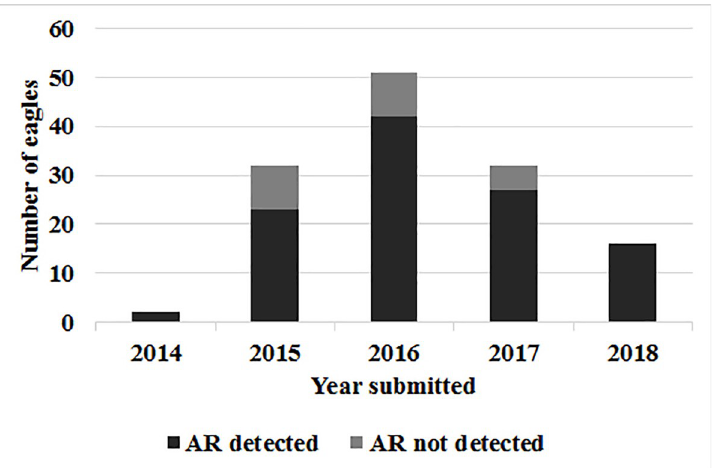
Fig 2. Bar graph depicting the number of eagles submitted to the Southeastern Cooperative Wildlife Disease Study, 2014–2018, that were tested for anticoagulant rodenticides and those in which one or more AR compounds were detected.